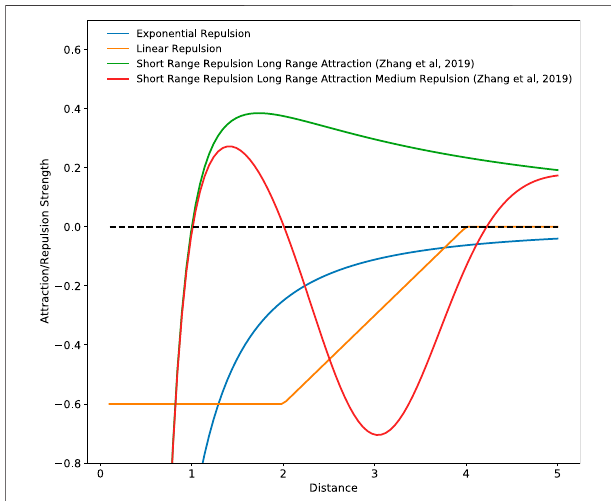
FIGURE3| Inter-agentinteractionforcesgeneratedbyvariousrepulsion and attraction schemes. Positive values indicate an attractive force and negative values indicate a repulsive